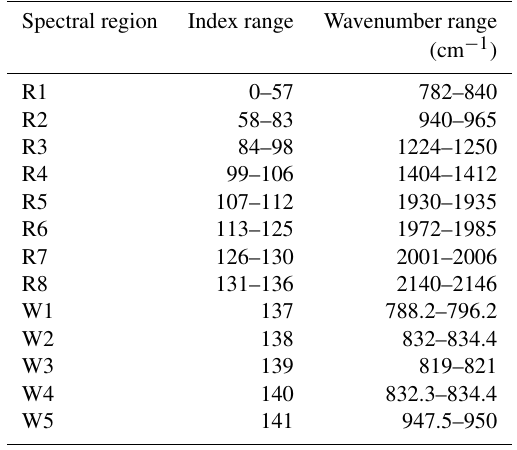
Figure 1. MIPAS measurements in Southern Hemisphere polar winter at three tangent altitudes from the same profile showing clear-air (light blue), optically thin (blue), and optically thick (dark blue) conditions. The gray bars indicate the wavenumber regions considered for PSC classification in this study. Table 2. PSC constituents, particle concentrations, and sizes cov- ered by the